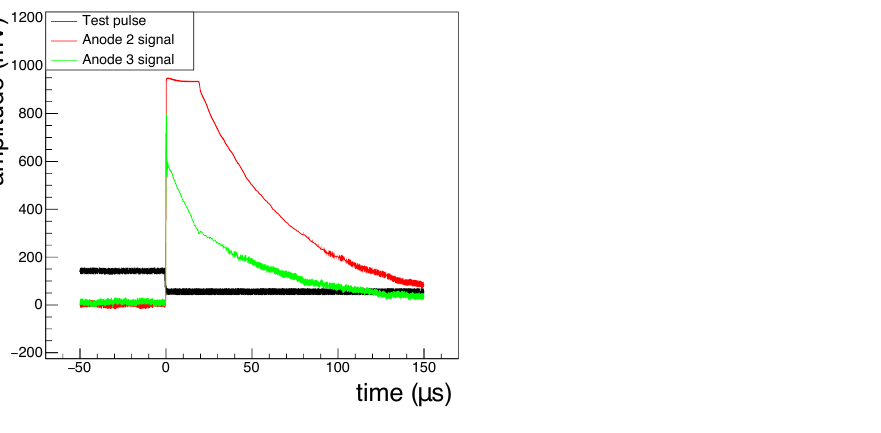
Figure 18. Waveform of a test pulse, coupled into the anode 1 mesh and the resulting amplified pulses (CR-112), as digitized by the HPTPC’s data acquisition